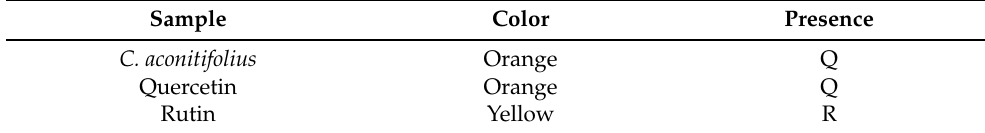
Figure 1. TLC results: ( a ) C. aconitifolius ethyl acetate extract, ( b ) Quercetin, ( c ) Rutin. Table 2. Colorimetric determination of flavonoids observed in thin-layer chromatography under UV light.